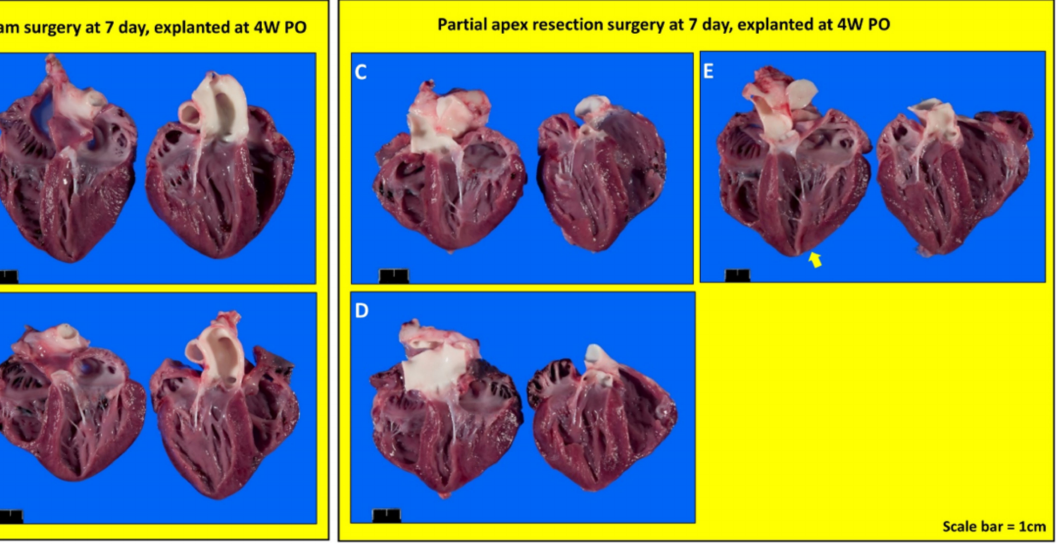
Figure 5. Gross anatomy photos. ( A ) Seven-day control (sham) heart from piglet #2071. ( B ) Seven-day control (sham) heart from piglet #2077. ( C ) Seven-day surgery heart from piglet #2073. ( D ) Seven-day surgery heart from piglet #2075. ( E ) Seven-day surgery heart from piglet #2076. Scale bar = 1